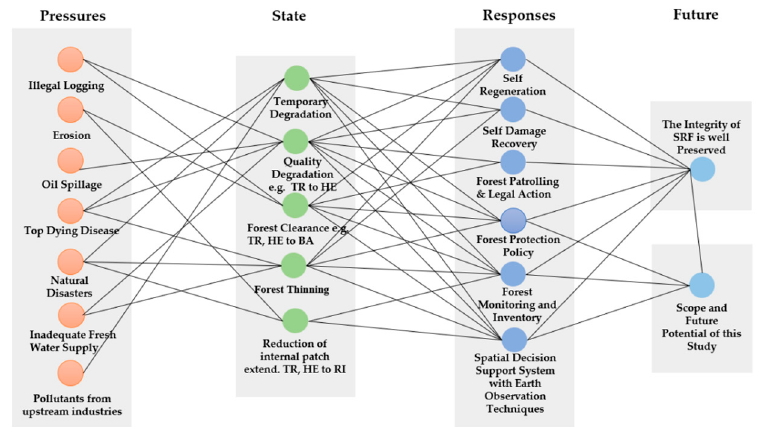
Figure 2. Conceptual framework of pressure–state–response–future for SRF (modified based on local SRF factors in [48]).